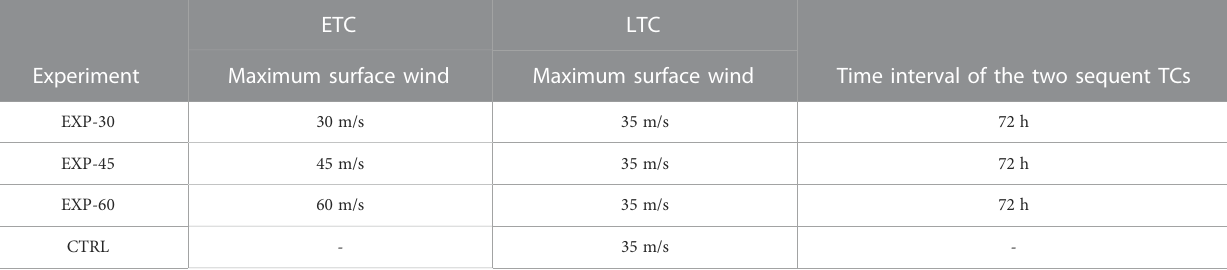
TABLE 1 Sensitivity experiments for the sequential TCs. The wind fi led for the, ETC., and LTC are constructed basedon the SLOSH method, with a moving speed of 6 m/s and a maximum winds radius of 50